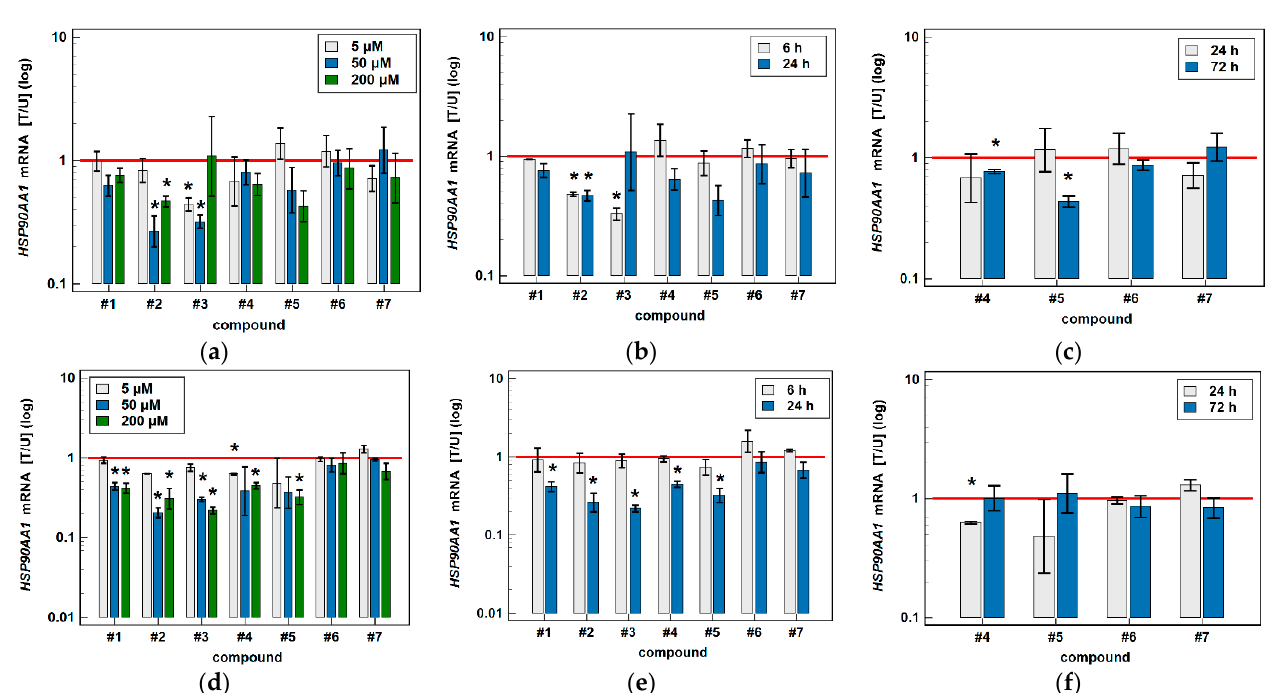
Figure 10. Effect of oxicams on HSP90AA1 expression in colorectal adenocarcinoma cell lines: ( a ) dose-dependent effect in Caco-2 cells treated for 24 h; ( b ) time-dependent effect in Caco-2 cells treated with 200 µM oxicams; ( c ) time-dependent effect in Caco-2 cells treated with 5 µM oxicams; ( d ) dose-dependent effect in HCT 116 cells treated for 24 h; ( e ) time-dependent effect in HCT 116 cells treated with 200 µM oxicams; ( f ) time-dependent effect in HCT 116 cells treated with 5 µM oxicams. Data presented on logarithmic scale. Bars represent mean expression ratio of treated-to-untreated cells [T/U] with 95% confidence interval (whiskers). Statistically significant differences between treated and untreated cells as analyzed by t-test for paired samples are indicated by asterisks (*). Horizontal solid red line represents gene expression in control (untreated samples). Compound #6 denotes piroxicam and #7—meloxicam.